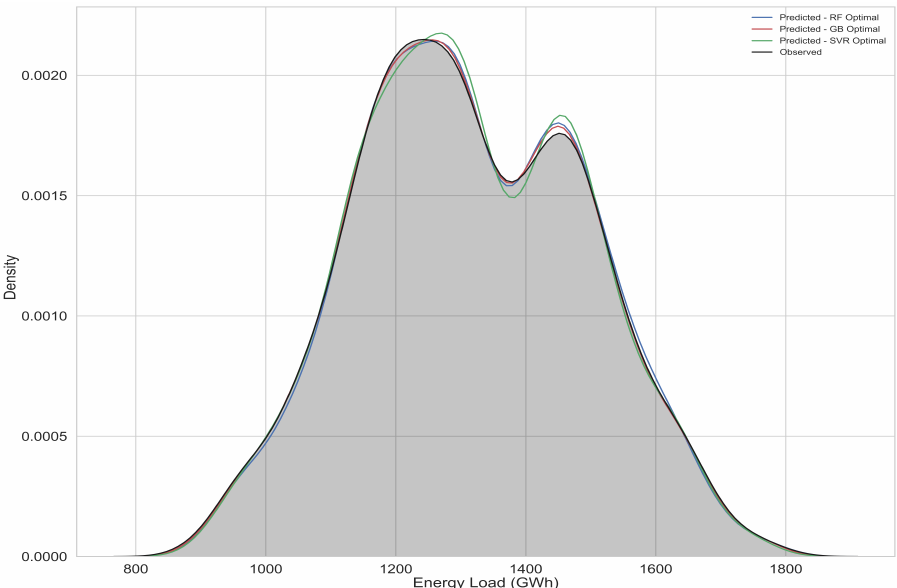
Figure 12. Density plot for the true observed data and the predictions generated by the trained